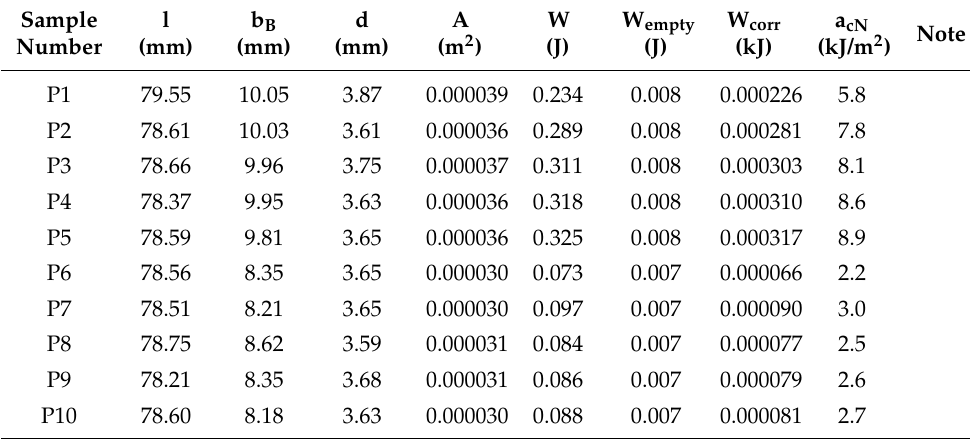
Table A20. Results of the notched impact tests and unnotched impact tests of PO_A,C.